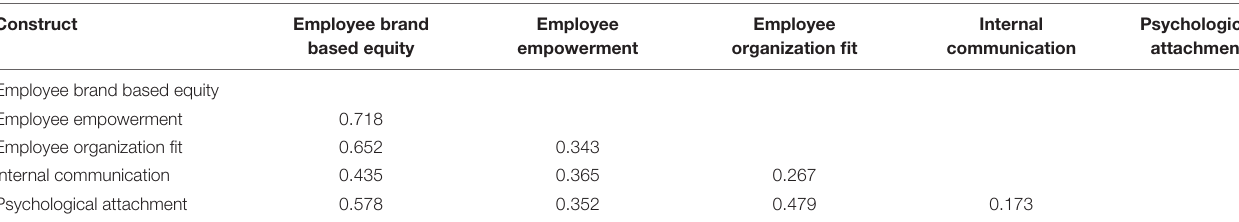
TABLE 4 | Discriminant validity [heterotrait–monotrait (HTMT)